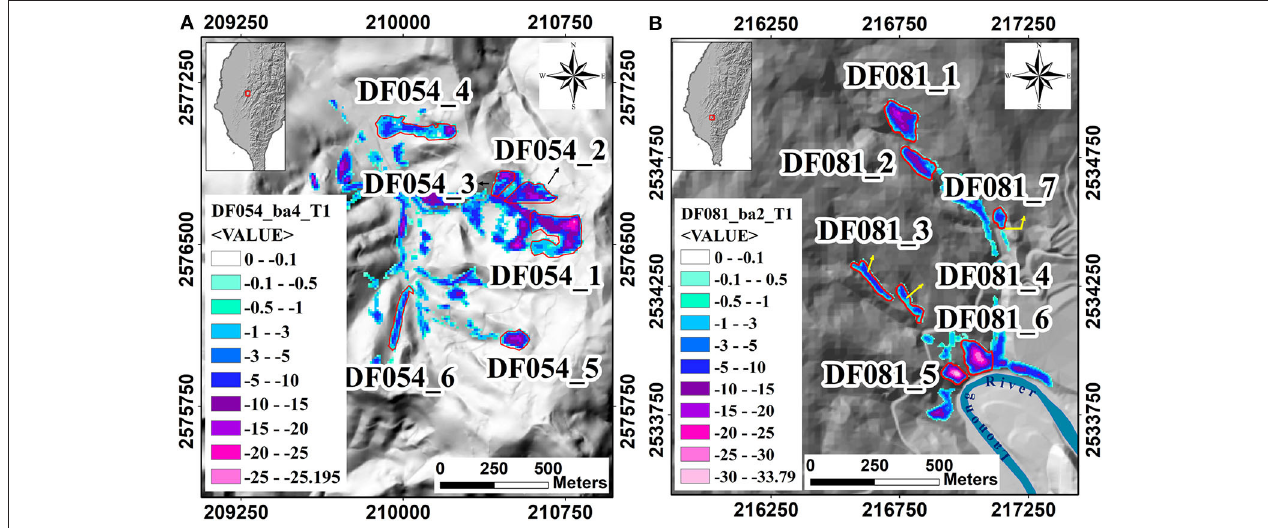
FIGURE 3 | Landslides in (A) the DF054 area, in the Longjiao River catchment, Dapu Township, Chiayi County and (B) the DF081 area in the Laonung River catchment, Maolin District, Kaohsiung City ( Central Geological Survey, 2010). Negative values of the color legends indicate landslide scarp depths and the positive values indicate the deposit thickness in meters. The sites outlined in red solid lines are the deep-seated landslides investigated in the present study. The TWD97 coordinate system is used.